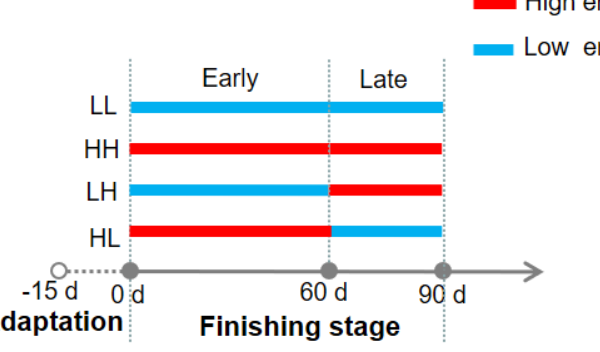
Figure 1. Energy supply order for each provision strategy. Table 1. Ingredient and chemical composition of the low- and high-energy diets.